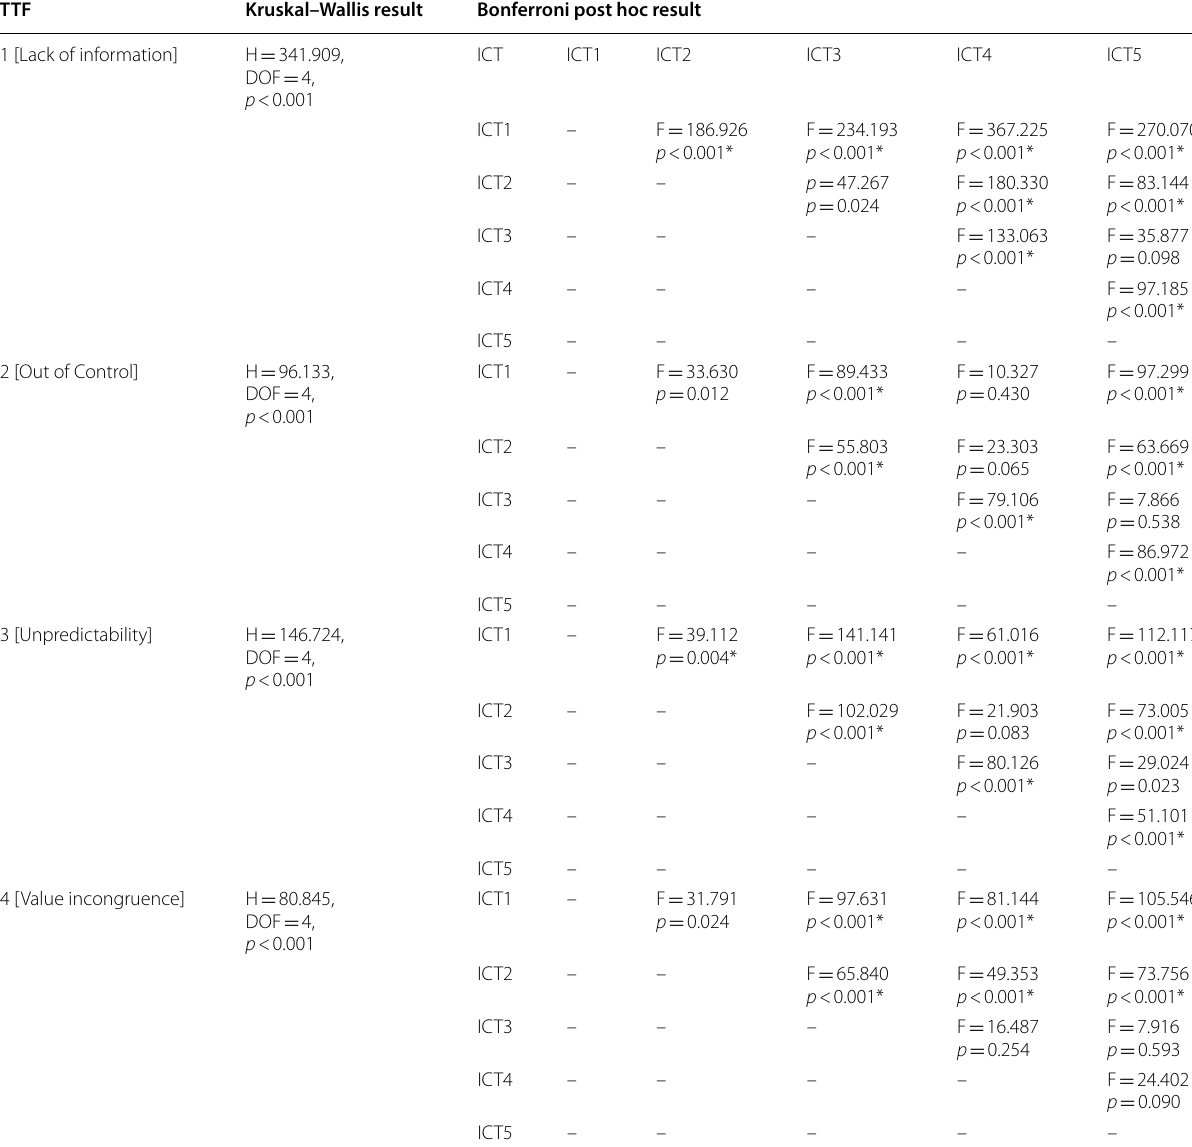
*statistical significance